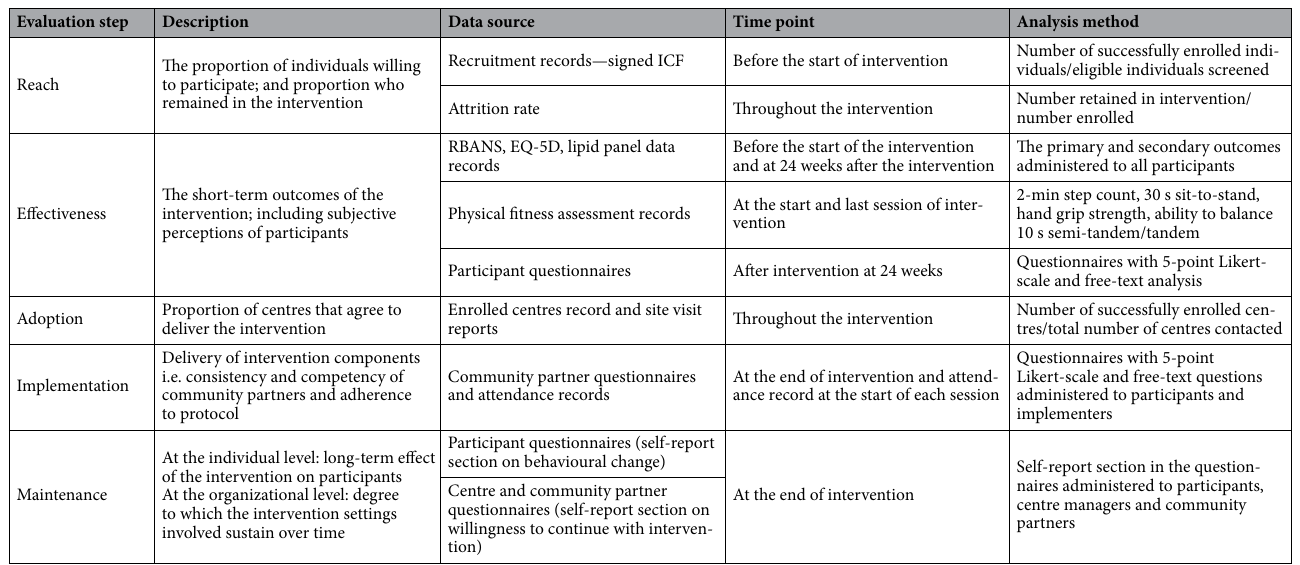
Table 2. Implementation evaluation measures, data sources and analysis method using RE-AIM